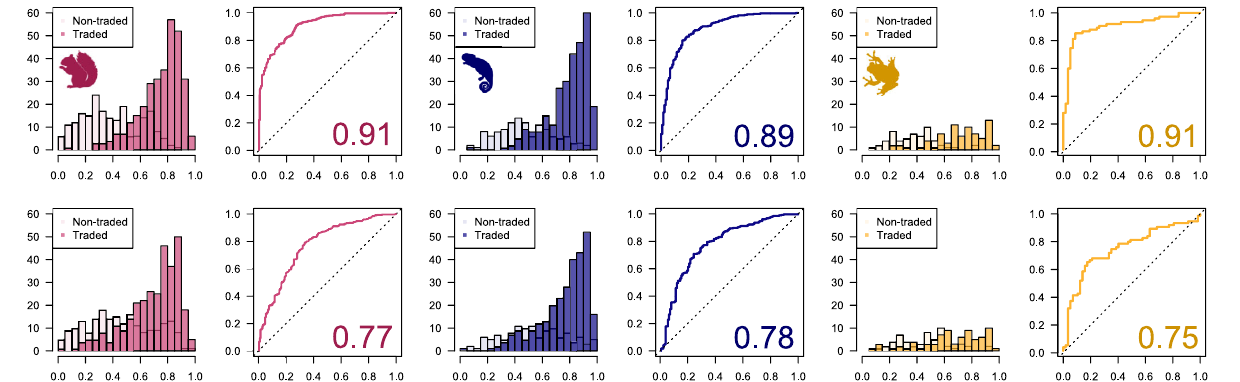
and non-traded species, while plots show receiver operating characteristic (ROC) curves and areas under the ROC curves (AUC). Silhouettes were obtained from phylopic.org under Public Domain licences.